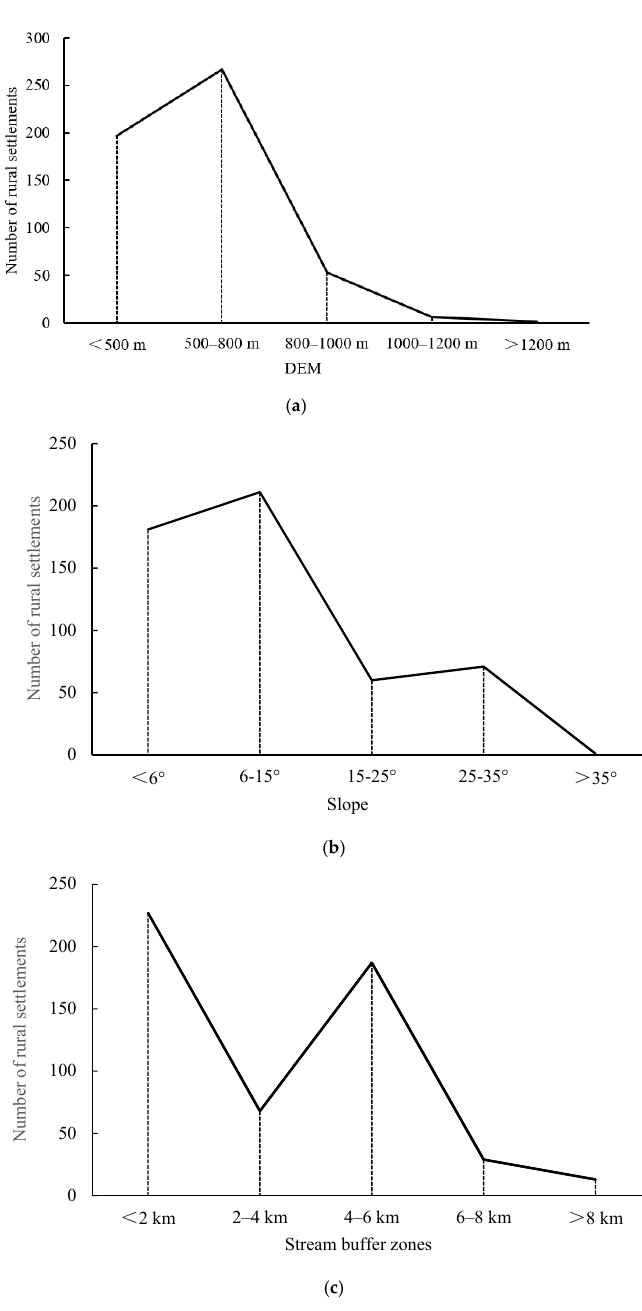
Figure 5. Distribution of rural settlements in the study area based on natural environmental factors. (a) Number of rural settlements at different altitudes; (b) Number of rural settlements on different slopes; (c) Number of rural settlements in different stream buffer zones